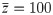
The distribution of average wealth 〈wz〉 vs. opportunities z at different temperatures in the Law of the Jungle setting of Fig 1 for a binomial distribution of opportunities of mean z¯=100.The left and right insets plot respectively the average frustration and average motivation vs. opportunities z.